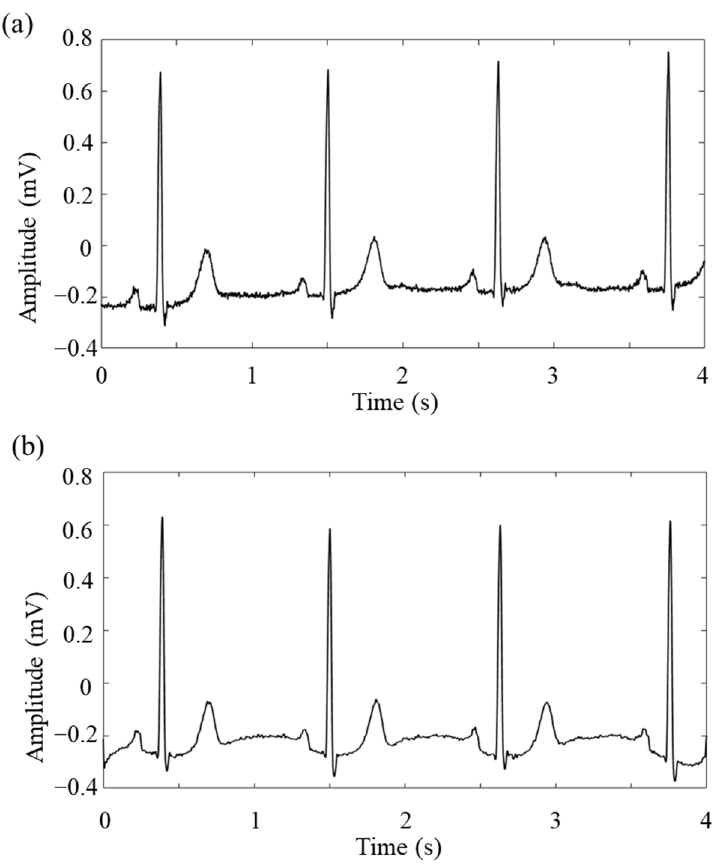
Figure 3. Schematic diagram of the ECG signal: ( a ) original; ( b ) after de-noising.